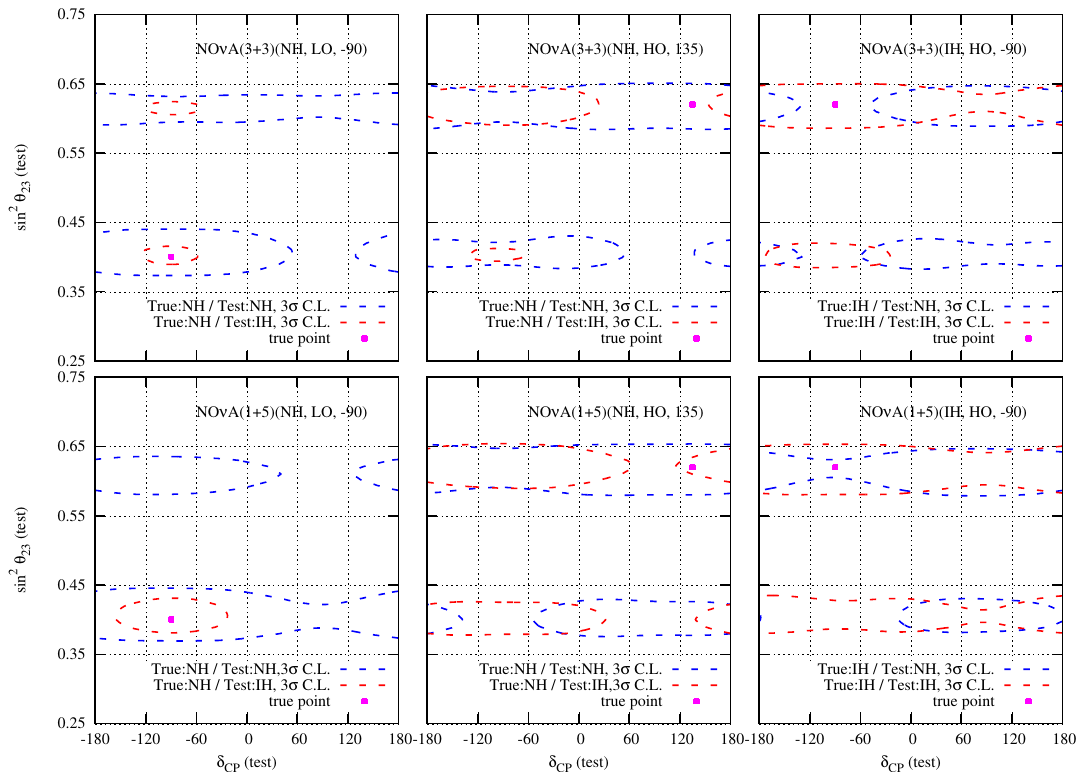
Figure 1 . Expected allowed regions in sin 2 (cid:18) 23 (cid:0) (cid:14) cp plane for a six years run of NO (cid:23) A, assuming one of the best-(cid:12)t points is the true solution. The left, middle and right columns represent (NH, LO, (cid:0) 90 (cid:14) ), (NH, HO, 135 (cid:14) ) and (IH, HO, (cid:0) 90 (cid:14) ) solutions respectively. The top and bottom rows are for (3 (cid:23) + 3(cid:22) (cid:23) ) and (1 (cid:23) + 5(cid:22) (cid:23) ) runs of NO (cid:23) A respectively. The blue (red) curves are there for test NH